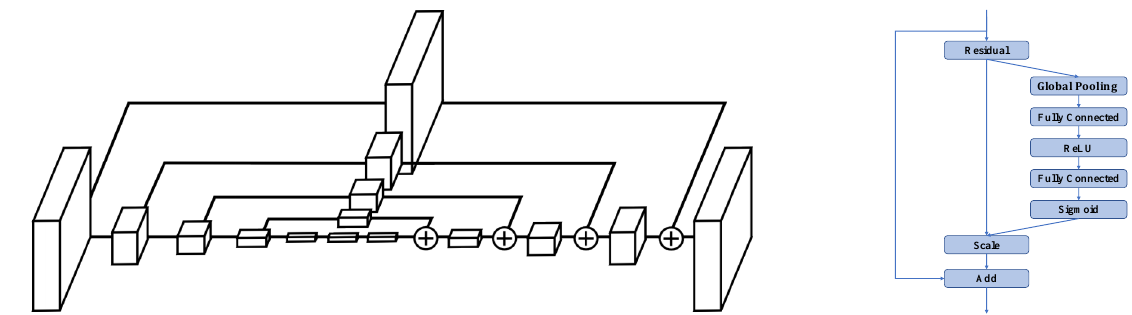
Figure 6. Illustration of the backbone network. Left : the structure of the Hourglass network [33]. Each box represents a residual block. Right : the structure of the SE-residual block. In SE-Hourglass, residual blocks are replaced by SE-residual